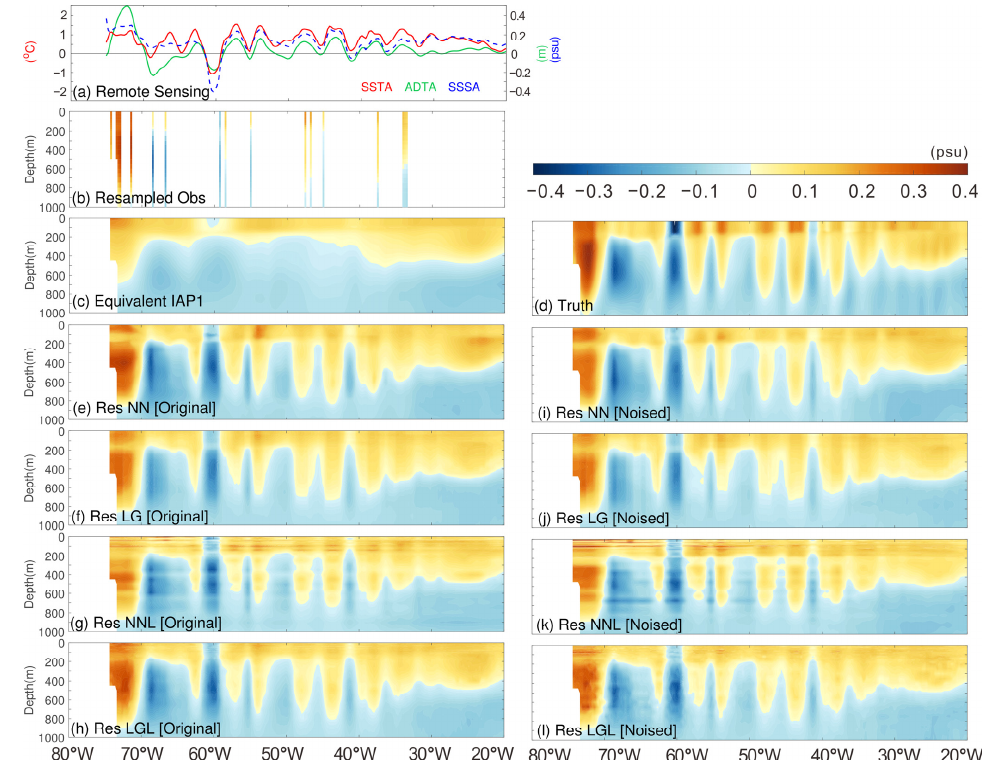
Figure 6. ( a ) Distribution of synthetic remote sensing: SSTA (left y axis), ADTA (right y axis), and SSSA (right y axis) at the sea surface. The vertical section along 35.375°N in the Gulf Stream region of ( b ) resampled salinity anomalies according to in situ observation, ( c ) equivalent IAP1° subsurface salinity anomalies, ( d ) truth value, ( e – h ) reconstructed data from experiments performed with the original synthetic dataset, and ( i – l ) reconstructed data from experiments performed with the noised synthetic dataset. The fields for January 2016 are shown. Figure 7 shows the vertical distribution of multiple parameters in the Kuroshio and its extension along 35.375°N. Figure 7a shows that the synthetic satellite SSSA data (which are independent data that do not participate in model training) exhibit extensive positive salinity anomalies, and the reconstructed data also exhibit widespread salinity anomalies near the sea surface, which indicates that the data are reconstructed well for the near- surface signals. Like the reconstructed fields for the Gulf Stream region shown in Figure 6, the reconstructed data absorb the small-scale signals of the remote-sensing signals and the large-scale information of equivalent IAP1°. The small-scale information is produced along the vertical section of the reconstructed fields. For example, the reconstructed fields in the 150°–170°E region exhibited zigzag distribution patterns for positive and negative salinity anomalies, which are an evident characteristic of small-scale signals.